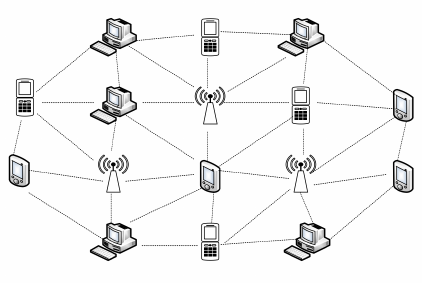
Figure 3. Structure diagram of